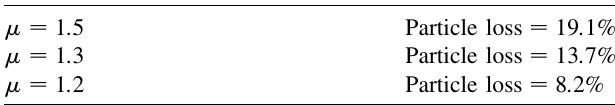
TABLE I. The mismatch and corresponding particle loss due to collimation.